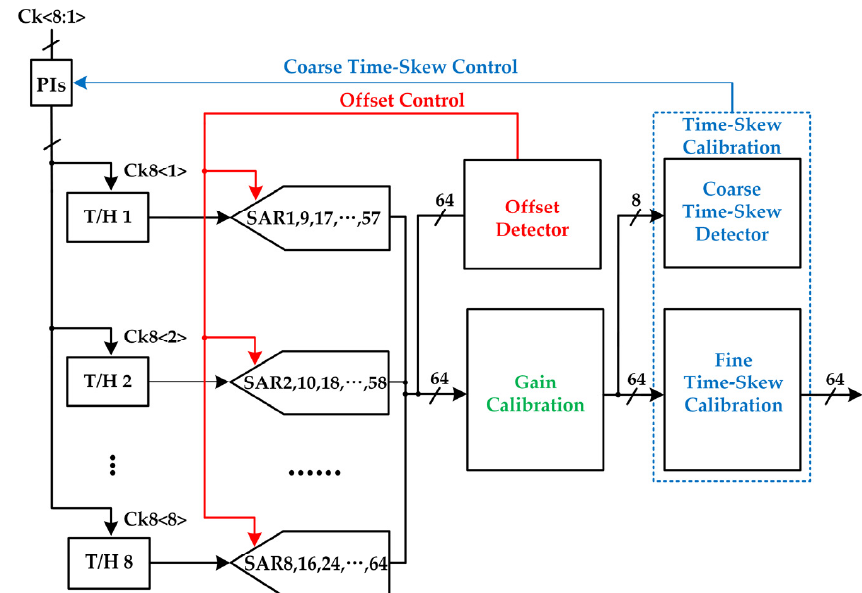
Figure 6. Overall calibration diagram.